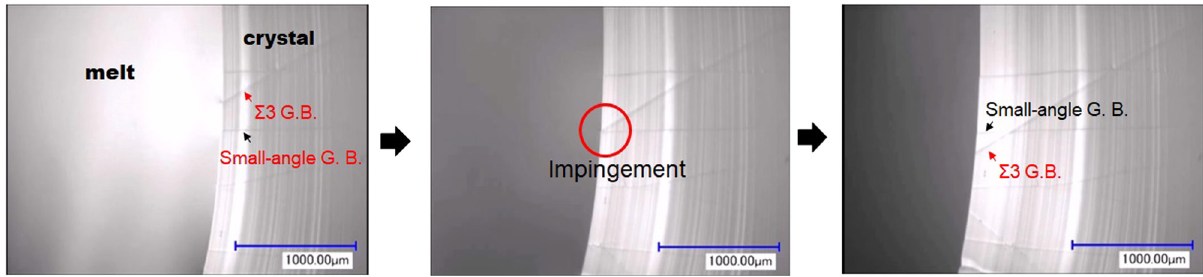
Figure 15: Observations of the impingement of a small - angle grain boundary and a Σ 3 twin boundary [ 112 ] . The grain boundaries penetrate each other and extend with growth.